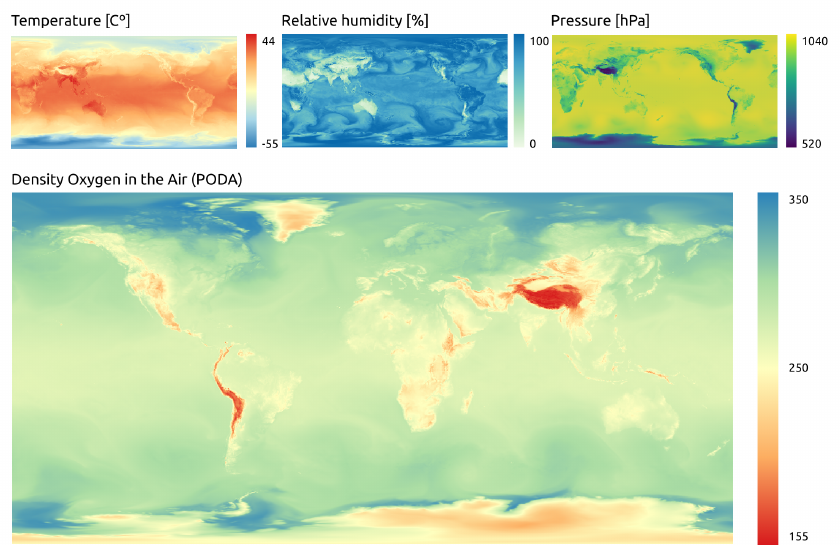
Figure 2. Map of 24 hours forecast of variables (on top Temperature, Relative Humidity and Pressure) used to calculate PODA (bottom map) 04/04/2019 at